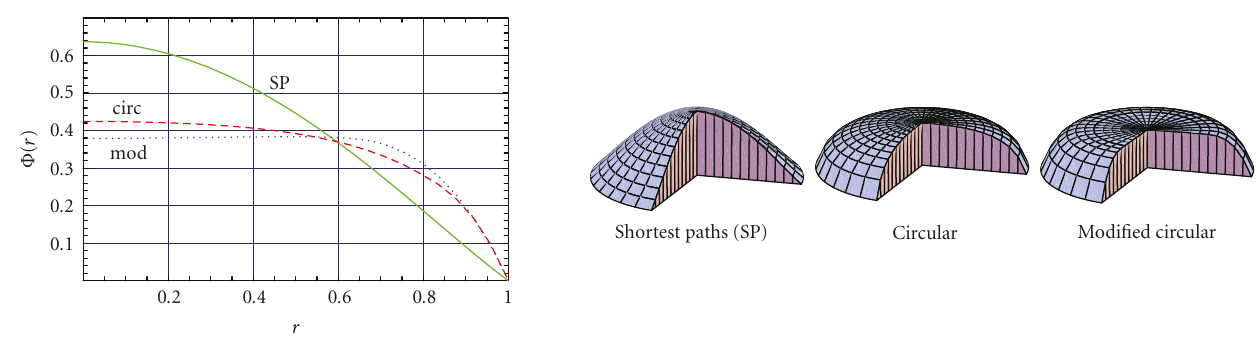
Figure 10: Scalar flux as the function of the radius for shortest paths, circular paths, and two-parameter modified circular paths with optimized parameters ( Λ = 1).